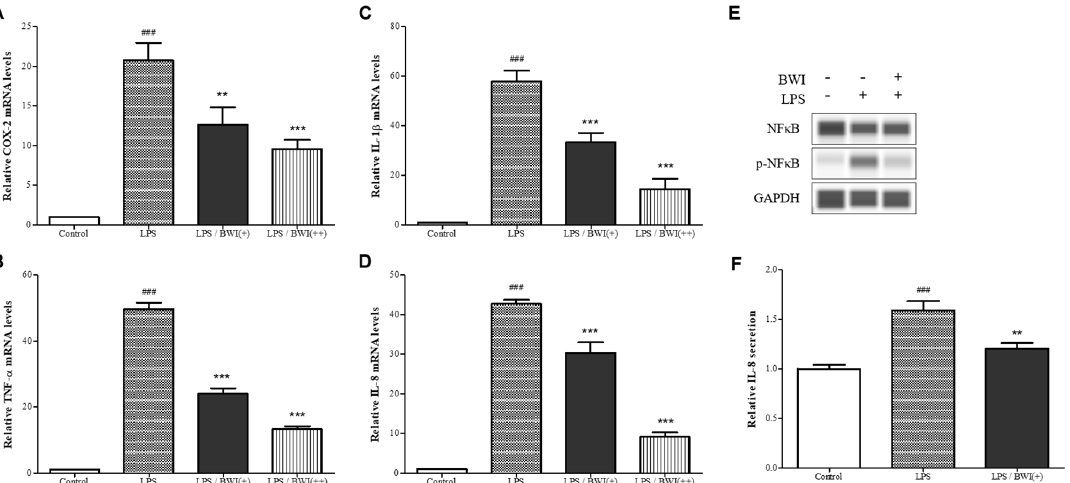
Figure 3. The reduction of LPS-induced inflammation in mono-layered Caco-2 cells co-cultured with differentiated THP-1 cells by BWI mix. ( A – F ) The relative mRNA expression levels of Cox-2, TNF- α, IL-β, and IL-8 were analyzed in the presence or absence of LPS and/or two doses of BWI mix (“+” and “++” were 1 × 10 6 and 1 × 10 7 cells/mL respectively). ( E ) Representative western blot data showing relative levels of NF κ B, phpsphorylated-NF κ B, and GAPDH (loading control) in harvested Caco-2 cells. (F) Secreted levels of IL-8 in the media were measured by ELISA. ### p < 0.001 vs. control; ** p < 0.01 vs. LPS; *** p < 0.001 vs. LPS.